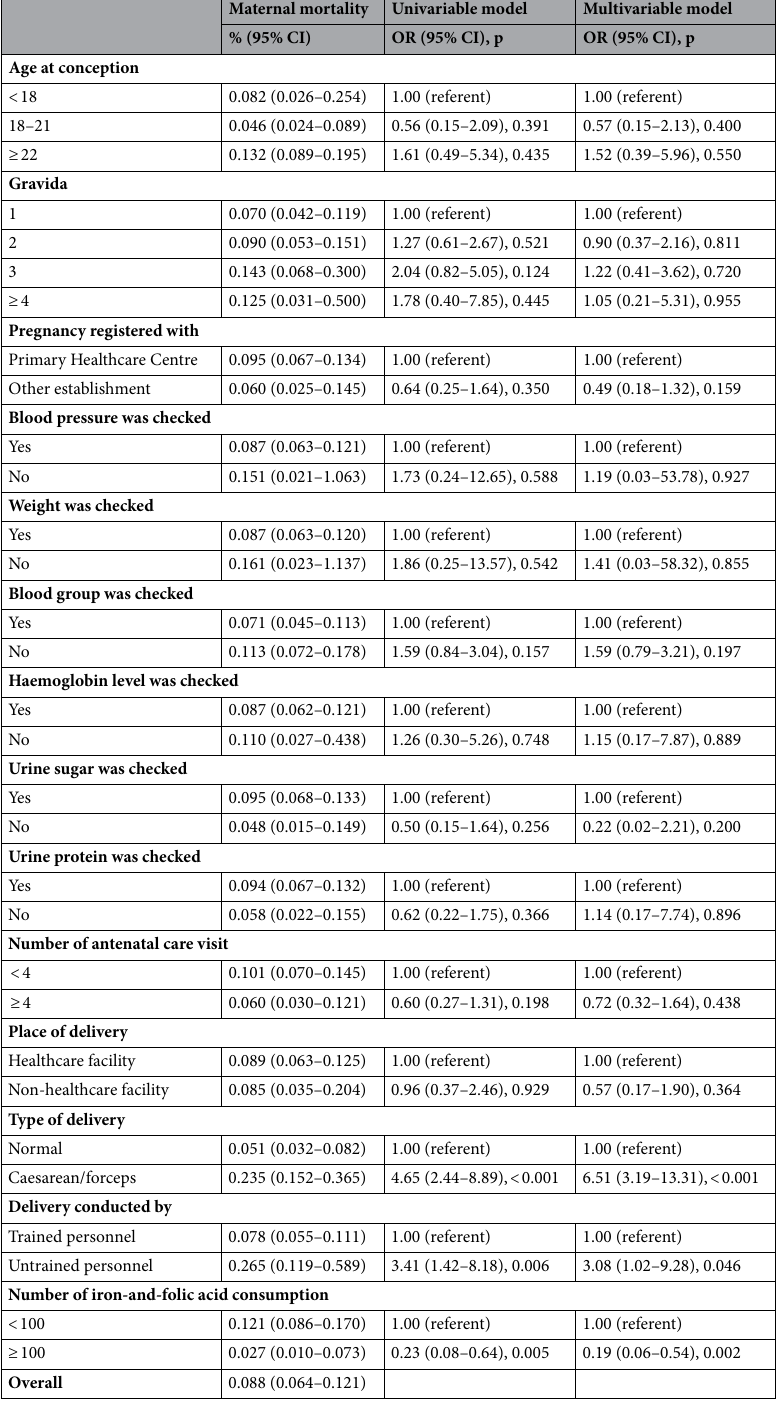
Table 2. Factors associated with maternal mortality. CI confidence interval, OR odds ratio, p level of